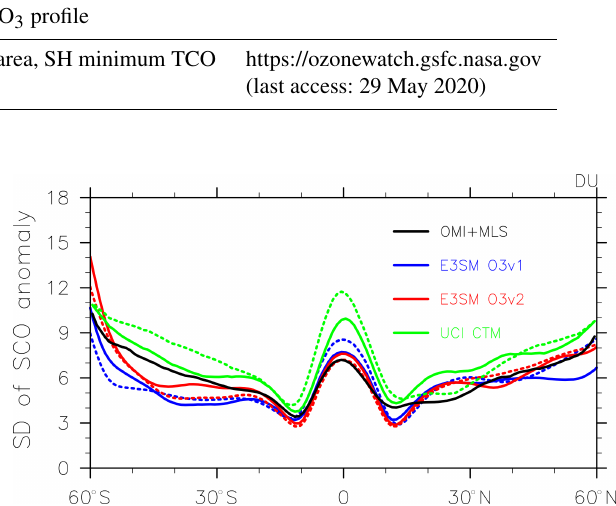
Figure 2. The SD (in Dobson units) of the zonal mean SCO monthly anomalies relative to the long-term average in Fig. 1. The OMI + MLS observations are for years 2005–2017. The model re- sults show long-term interannual variability and are from two differ- ent 13-year periods: E3SM data for 1995–2007 (dashed lines) and 2002–2014 (solid lines) and UCI CTM data for 1992–2004 (dashed line) and 2005–2017 (solid